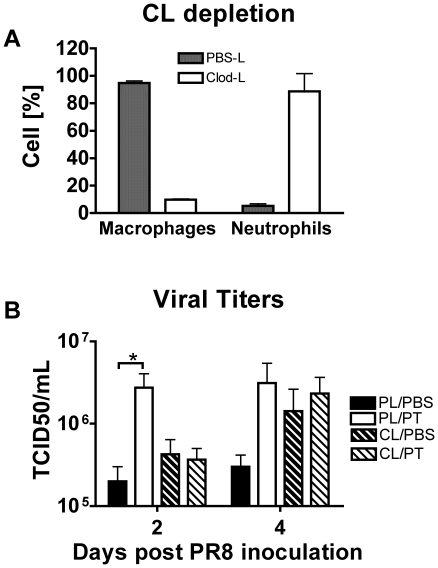
PT targets AM to enhance early viral titers and suppresses early pro-inflammatory airway responses.Groups of BALB/c mice were intranasally inoculated with 100 µL clodronate liposomes (CL) to deplete AM or with PBS liposomes (PL) as a control. (A) Percent of resident AM and neutrophils in the airways (BAL) two days after CL and PL treatment. (B) CL- and PL-treated mice were intranasally treated 2 days later with 100 ng of PT or an equal volume of PBS and infected with influenza PR8 (600 PFU) virus 24 h after PT/PBS treatment. Mean pulmonary viral titers were determined on days 2 and 4 post virus inoculation. n = 4 mice/treatment group. *Significantly different from control (P<0.05).